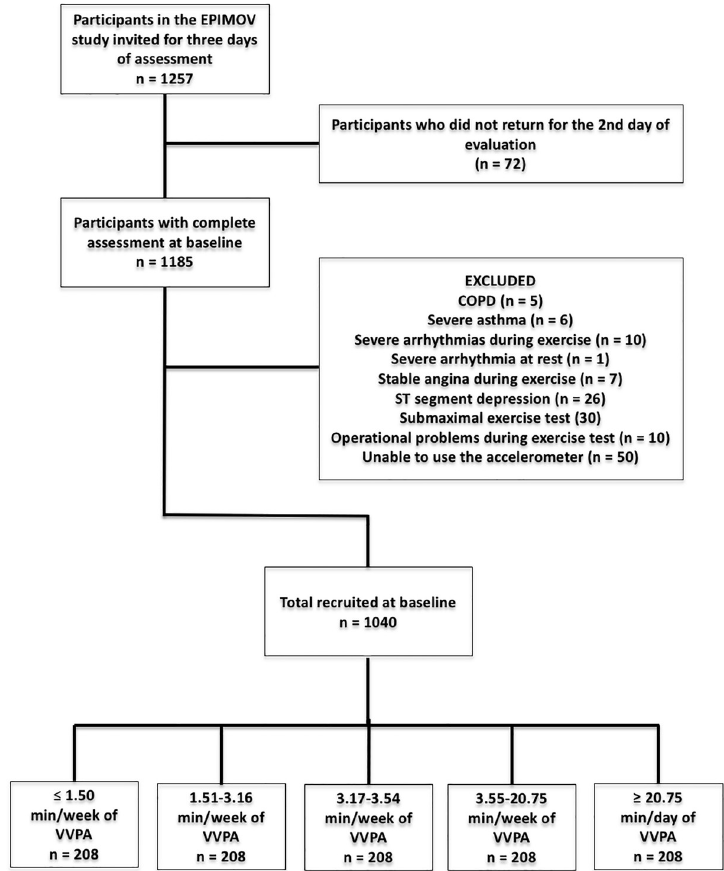
Fig 1. Flowchart of the study. EPIMOV: The Epidemiology and Human Movement Study. COPD: chronic obstructive pulmonary disease; VVPA: very vigorous physical activity.